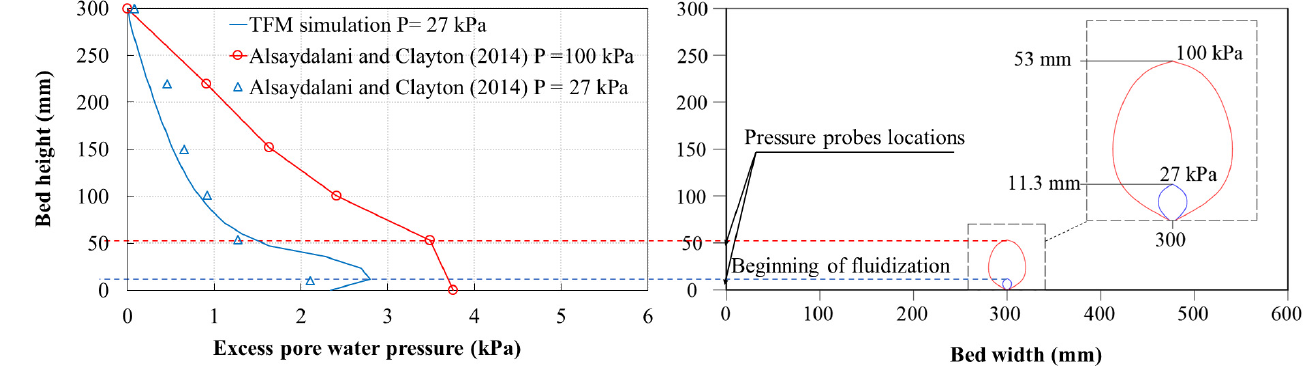
Figure 5. A comparison between the predicted initiation of fluidization and from the TFM simulation and the experimental data.